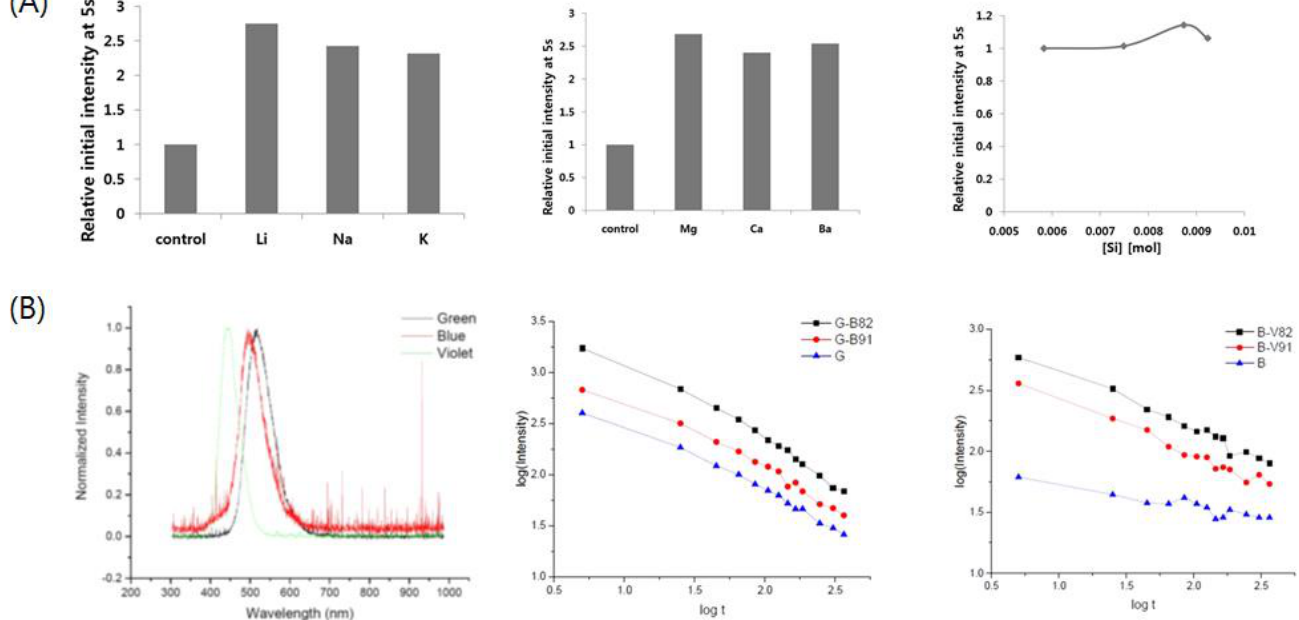
Figure 5. Various efforts to enhance the photoluminescence intensity of lanthanide-doped alkaline earth aluminate phosphors ( A ) Enhanced photoluminescence intensity by alkali metal (left), alkaline earth metal (middle), and Si (right) ions doping. Adapted from [12] under Creative Commons Attribution (CC BY) license. ( B ) (left) Emission spectra of the green (SrAl 2 O 4 :Eu 2+ , Dy 3+ ), blue (Sr 4 Al 14 O 25 :Eu 2+ , Dy 3+ ), and violet (CaAl 2 O 4 :Eu 2+ , Nd 3+ ) phosphors used for the phosphor mixing method with the aim of energy transfer between them. (middle) Photoluminescence decay curves in log scale for the green and blue phosphors mixed sample, showing enhanced luminescence intensity of green phosphor by mixing with the blue phosphor. (right) Photoluminescence decay curves in log scale for the blue and violet phosphors mixed sample, showing enhanced luminescence intensity of blue phosphor by mixing with the violet phosphor. Adapted from [14] under Creative Commons Attribution (CC BY) license.